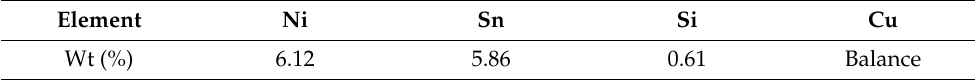
Table 1. The chemical composition of the Cu–6Ni–6Sn–0.6Si alloy. Element Ni